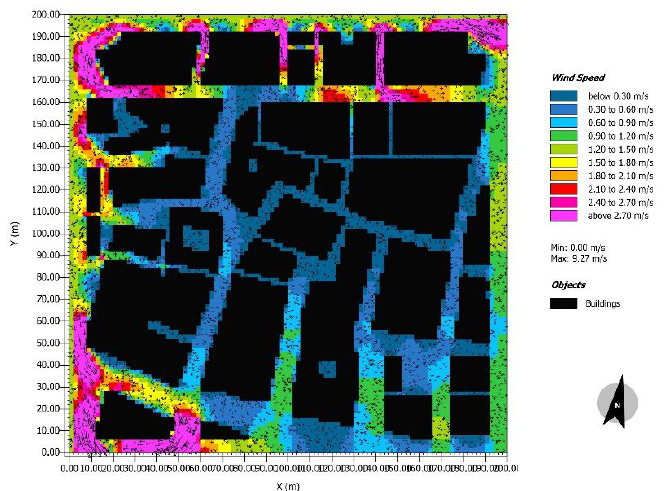
Figure 18. Wind speed and direction for Al Fahidi urban form at 2:00 p.m. on 15 August. (ENVI- met).